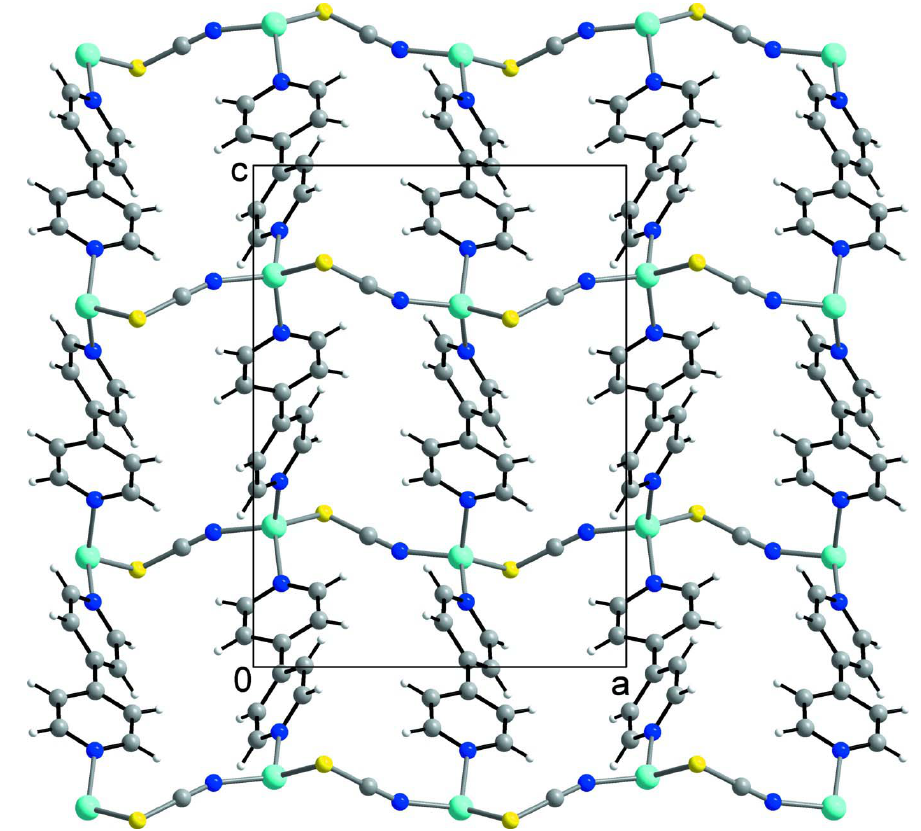
Figure 2 Crystal structure of the title compound with view along the b